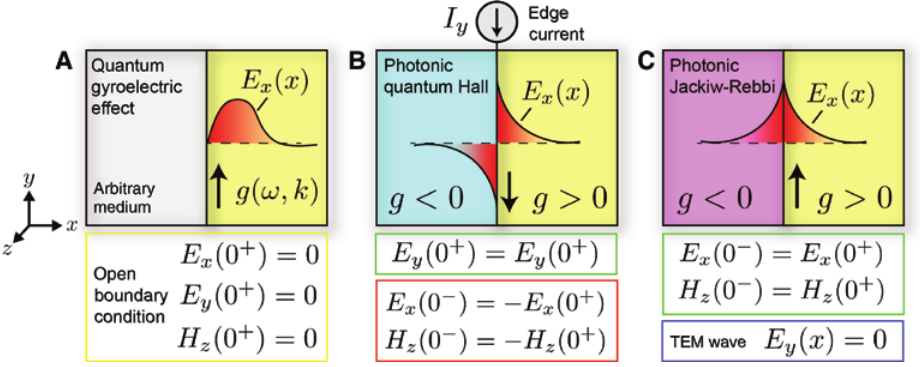
Figure 1: Overview of the three unidirectional edge wave platforms in two-dimensional gyroelectric media. (A–C) are schematics of the quantum gyroelectric effect (QGEE), photonic quantum Hall (PQH), and photonic Jackiw-Rebbi (PJR) edge states, respectively. The characteristic spatial profile of E ( x ) is displayed for each edge state along with the corresponding boundary conditions. x (A) The QGEE is a topologically protected unidrectional (chiral) edge state and exists at the boundary of any medium – even vacuum. The QGEE is fundamentally tied to nonlocal (spatially dispersive) gyrotropy g ( ω , k ) and can never be realized in a purely local model. (B) The PQH edge state is the photonic analog of the quantum Hall effect and hosts a high-frequency edge current I . The presence of the edge y ≠ 0 creates a discontinuity in the fields across the boundary, E current I (0 − ) ≠ E (O + ) and H (0 − ) ≠ H (O + ). (C) The PJR edge state is the photonic y x x z z ≠ 0 and is completely equivalent of the inverted mass problem arising in the Dirac equation. This state possesses no edge current I y transverse electro-magnetic (TEM) as the longitudinal field vanishes entirely E ( x ) = y